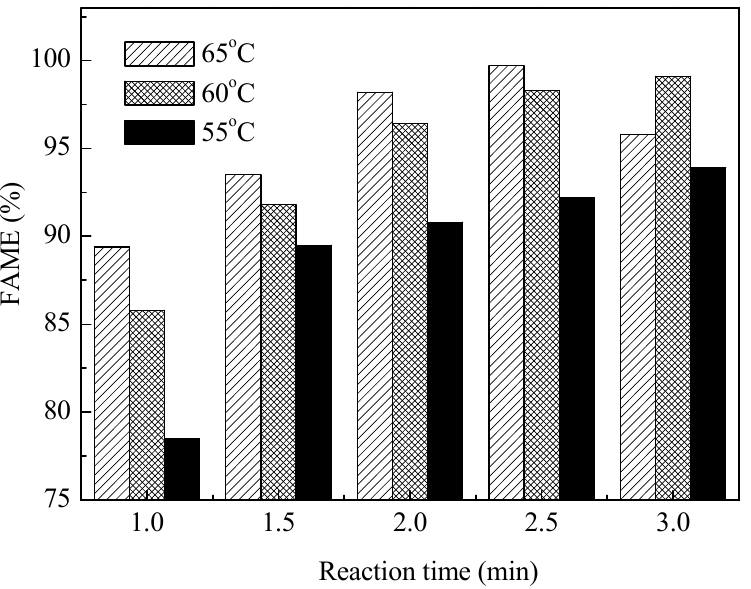
Figure 5. Effects of reaction time and reaction temperature on the biodiesel conversion. Reaction conditions: a 12:1 molar ratio, an NaOH catalyst of 0.8 wt %, reaction temperatures of 55, 60 and 65 °C, a reaction time ranging from 1–3 min, and a microwave power of 600 W.